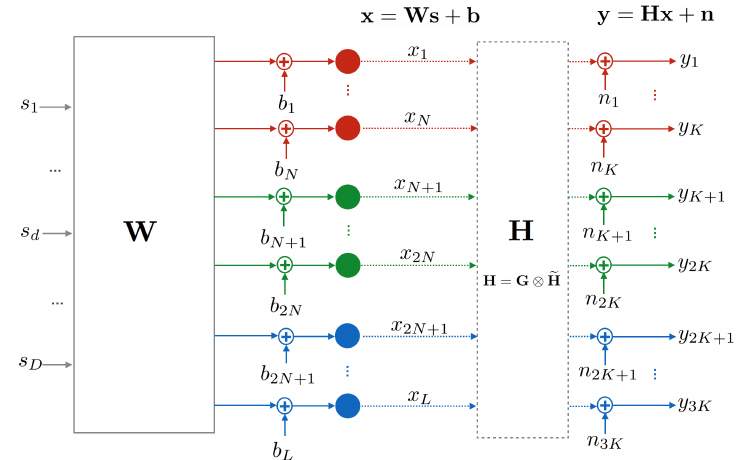
Figure 2. Block diagram of the system considered. A total of L = 3 N LEDs transmit D = 3 K symbol streams over L LEDs to K users with